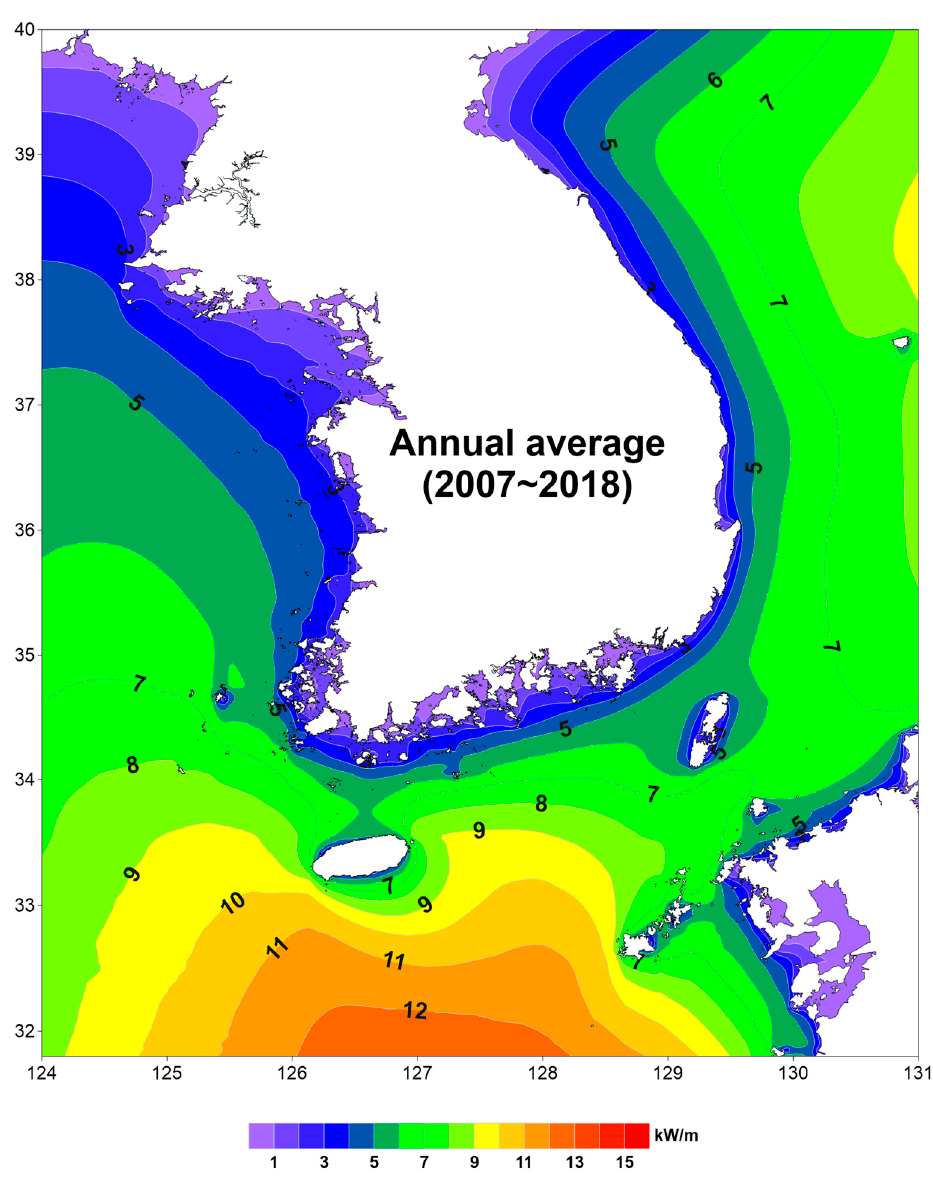
Figure 6. Average wave energy over 12 years from 2007 to 2018.